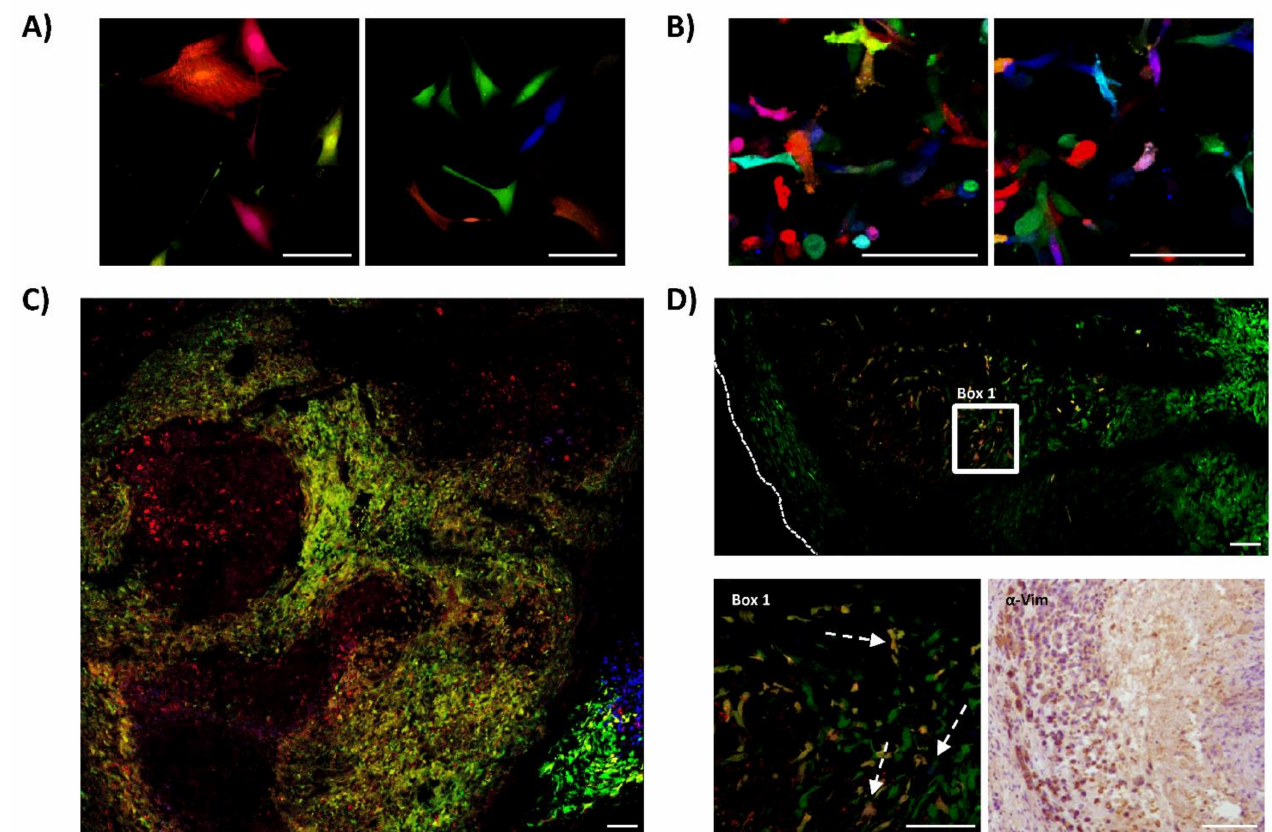
Figure 3. Canine and human primary OS cells contain few cells with tumor-propagating potential. The figure shows the results obtained from studying the clonal composition of tumors generated by canine (Laikos) and human (531B) primary samples in immunodeficient mice. ( A ) Representative confocal microscopy images of Laikos-RGB cells in vitro; white bars = 100 µ m. ( B ) Representative confocal microscopy images of 531B-RGB cells in vitro; white bars = 100 µ m. ( C ) Representative confocal microscopy image of Laikos-RGB tumors, note the globular clonal patches of colors; white bars = 100 µ m. ( D ) Representative microscopy images of 531B-RGB tumors. At the top of the panel, a representative confocal microscopy tumor map. At the lower-left, a detailed view of the previous image (Box 1) showing the clonal growth of a bright green clone and some low-frequency clones of different clonal origin (white arrows). Human cell identity was confirmed by immunohistochemistry (anti-vimentin) and is shown at the lower-right. White bars = 100 µ